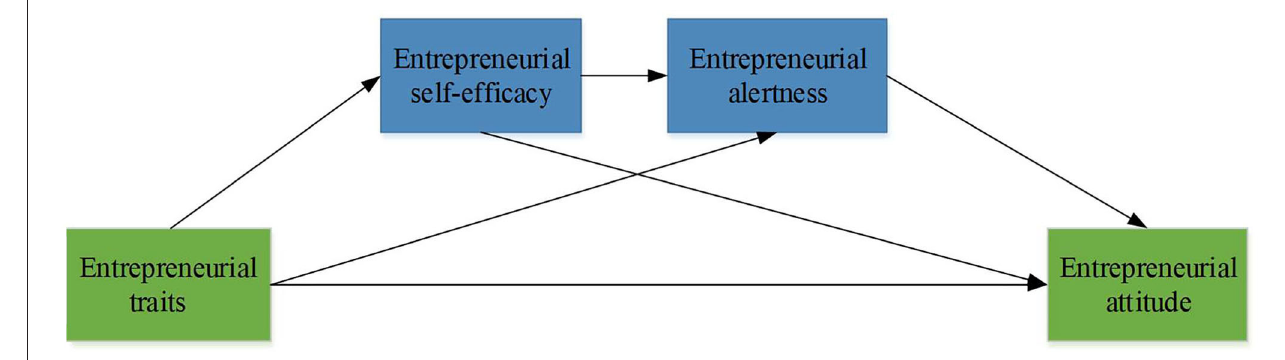
FIGURE 3 | Chained mediation model.